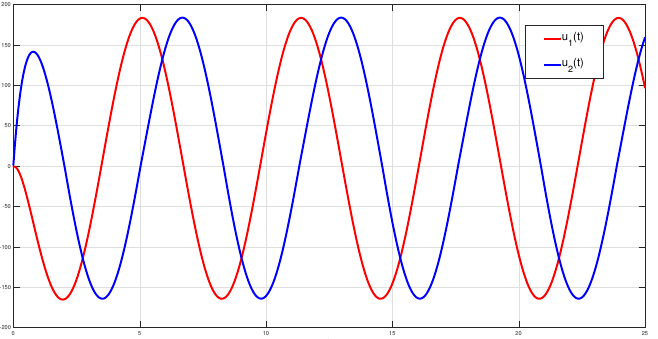
Figure 7. The time responses of the states u 1 ( t ) and u 2 ( t ) of system (71) for the external inputs